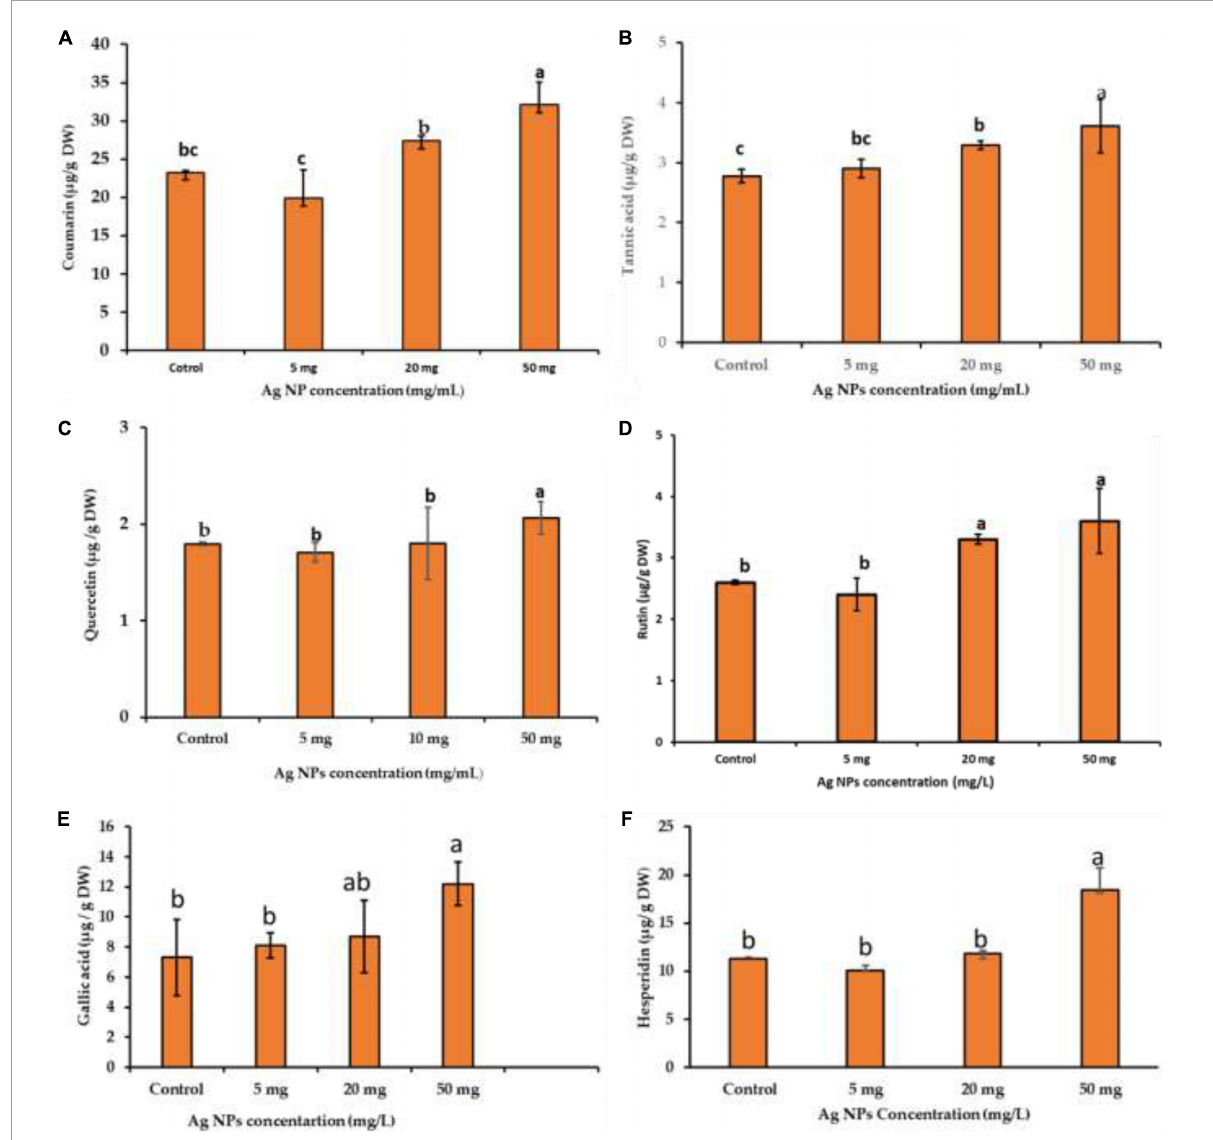
FIGURE7 The impact of different concentrations of biogenic AgNPs on bioactive compound production; (A) coumarin, (B) tannic acid, (C) quercetin, (D) rutin, (E) gallic acid, and (F) hesperidin of callus of J. procera . a , b , c Means within the same column with different superscripts differ significantly ( P <